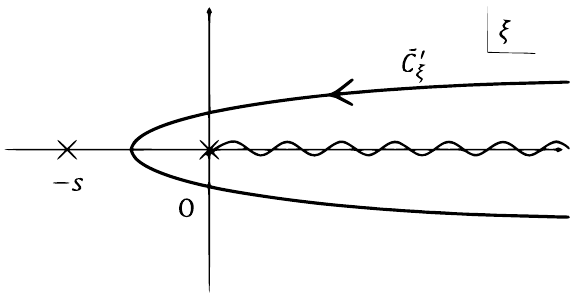
Figure 3 . Integration contour ~ C 0